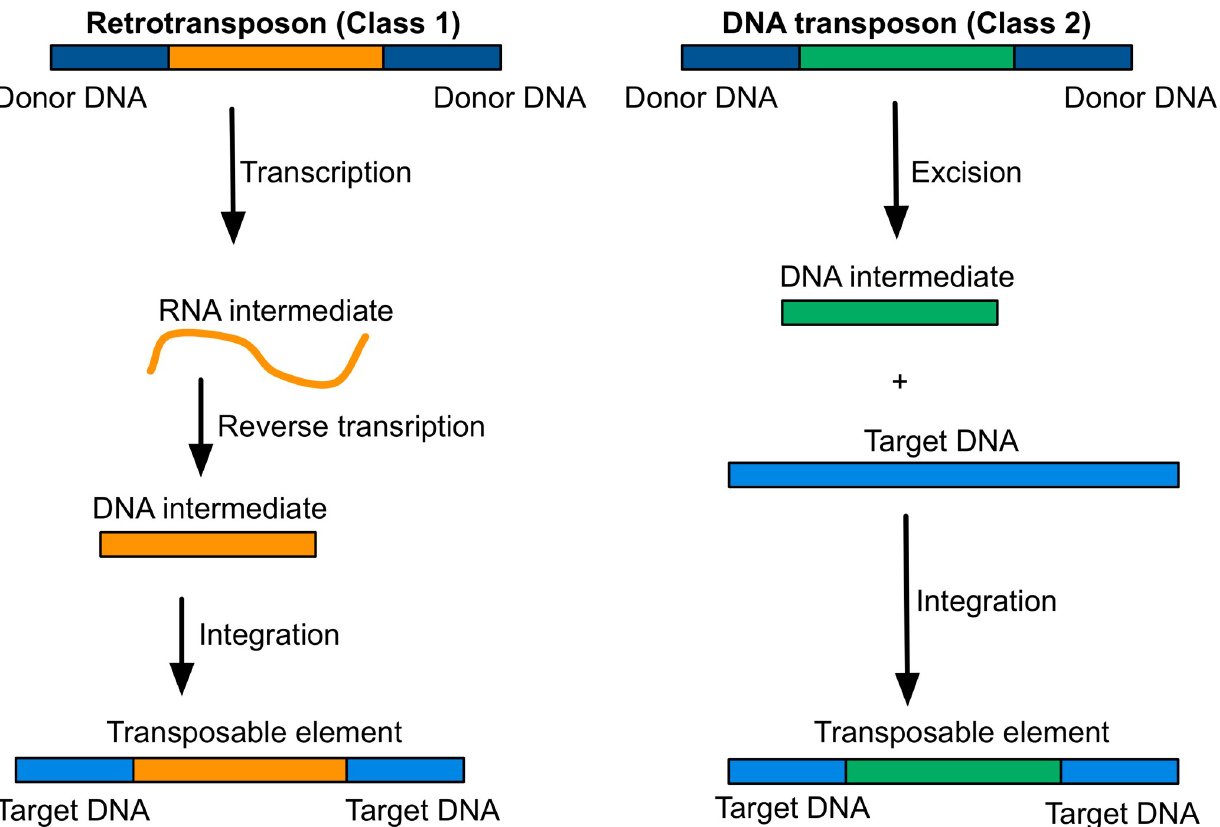
Fig 4. Transposable elements self-replicate through two main mechanisms: via an RNA intermediate ("copy-and-paste"; class 1) or straight excision- insertion ("cut-and-paste"; class 2).